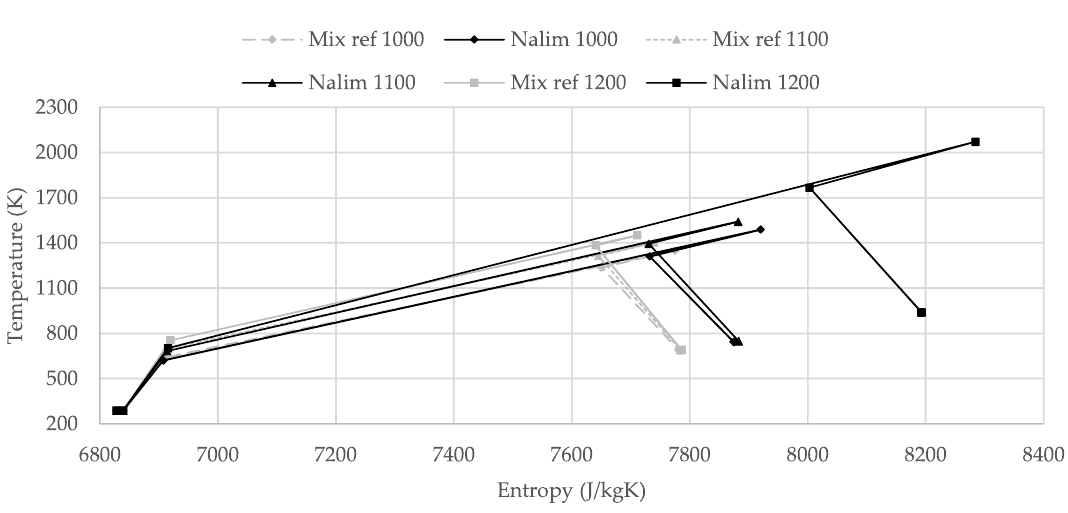
Figure 8. TS-diagrams of the simple cycle for Mix ref and Nalim’s PGC model at different blade temperature constraints.